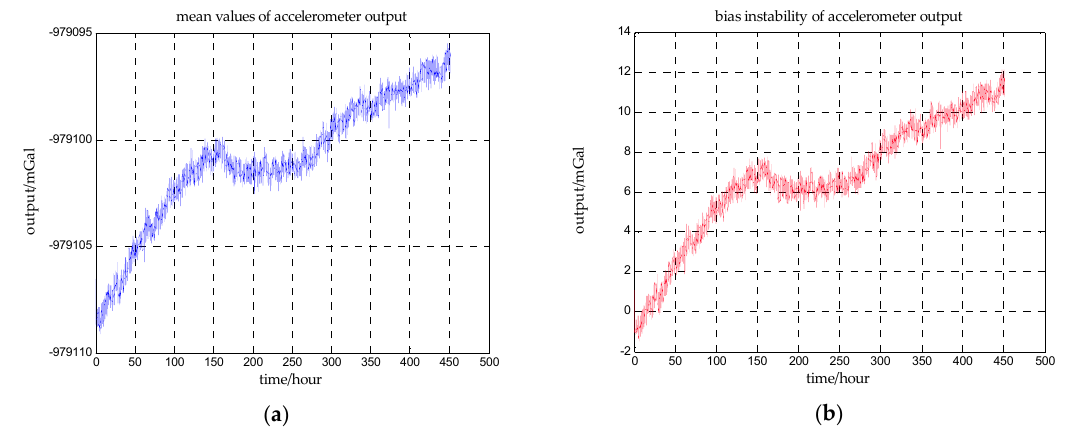
Figure 9. ( a ) is the mean values of the accelerometer outputs every one hundred seconds, and ( b ) is the bias instability of the accelerometer.